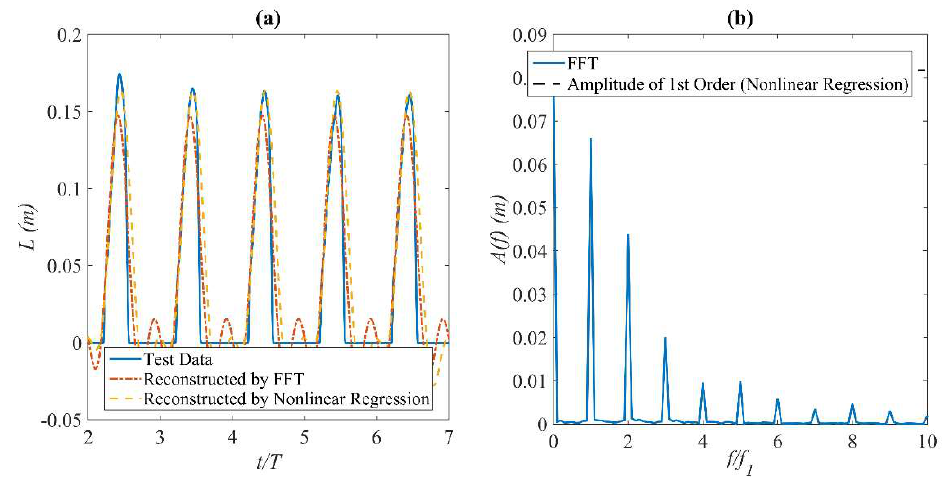
Figure 5. Example of processing wave run-up data in regular waves, ( a ) comparison of FFT results and regression results; ( b ) high frequency noise and reduced peak in FFT.